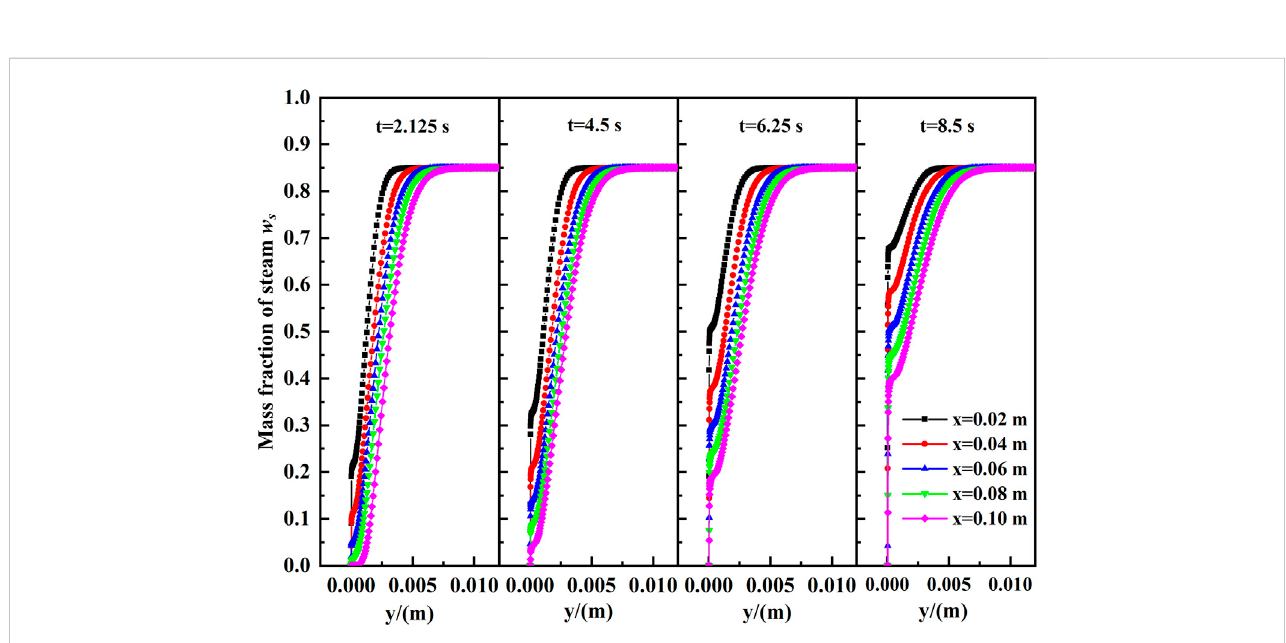
FIGURE 8 Mass fractions of steam in different positions on the wall in Case